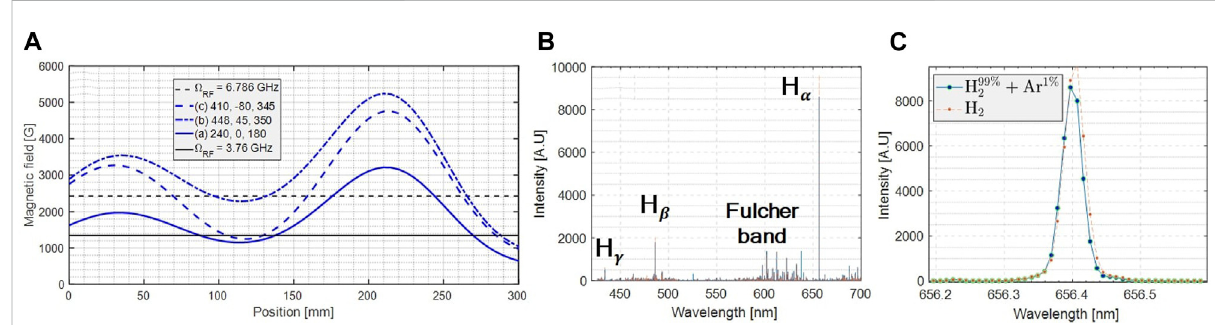
FIGURE 2 (A) Numerical calculation of the magnetic fi eld pro fi les as function of solenoids currents, for the three con fi gurations explored with OES, as reported in the legend. The microwave frequency ( B RF = m e 2 π f RF / e ), f RF = 6.786(3.76) is drawn as solid (dashed) black line. (B) Spectra of emission- linesfromH 2 plasma(orange)andH 99% 2 + Ar 1% gas-mixtureplasma(blue).H-Balmerlinesareindicated,alongwiththeFulcher- α bandQ-branchlines → a 3 Σ + ) . (C) Zoom-in of the H α lines for both the single species and gas-mixture, for the high-frequency f ( d 3 Π − u g 10 – 2